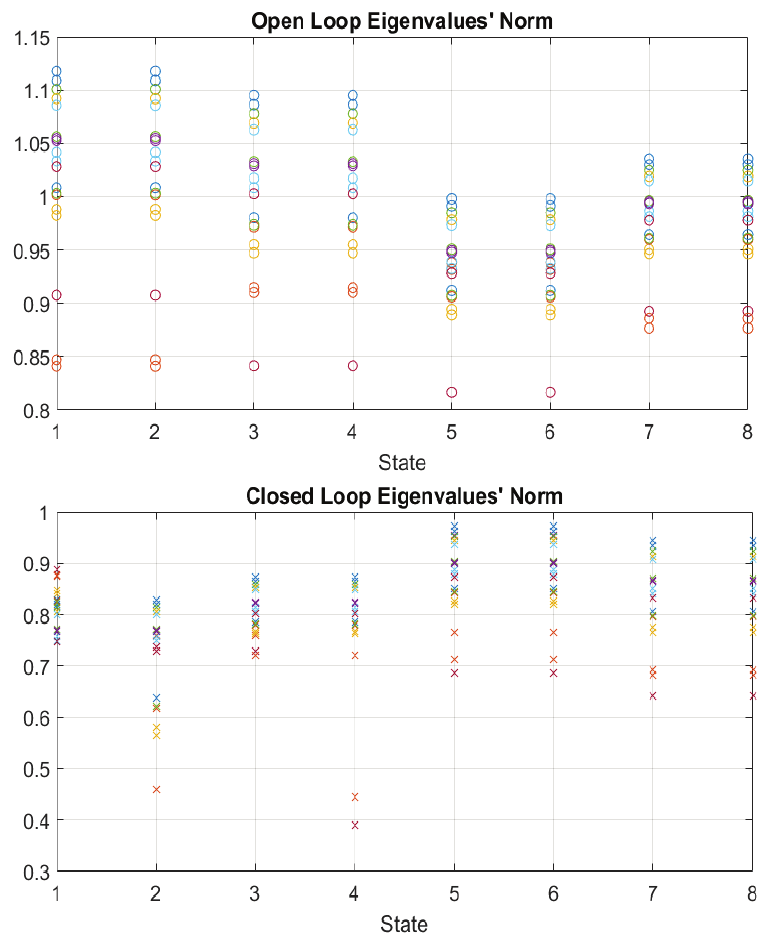
Figure 11. Sensitivity analysis of the stability property for the proposed system.